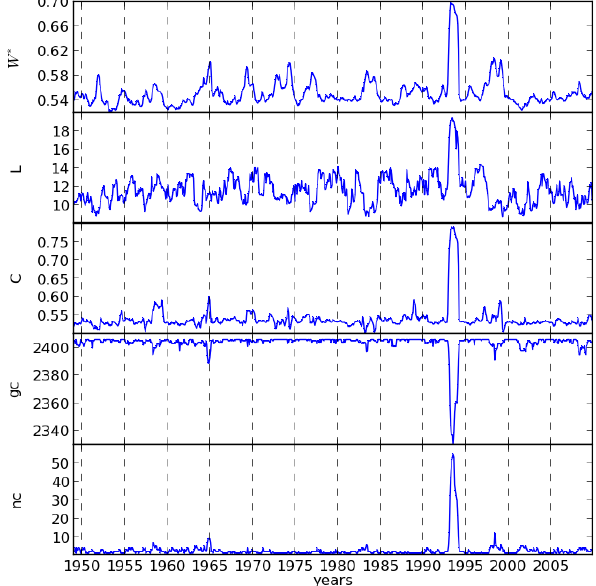
Fig. 13. Evolution of the graph-theoretical properties of the extra– tropics subgraph. Fig. 11. Evolution of the graph-theoretical properties of the extra-